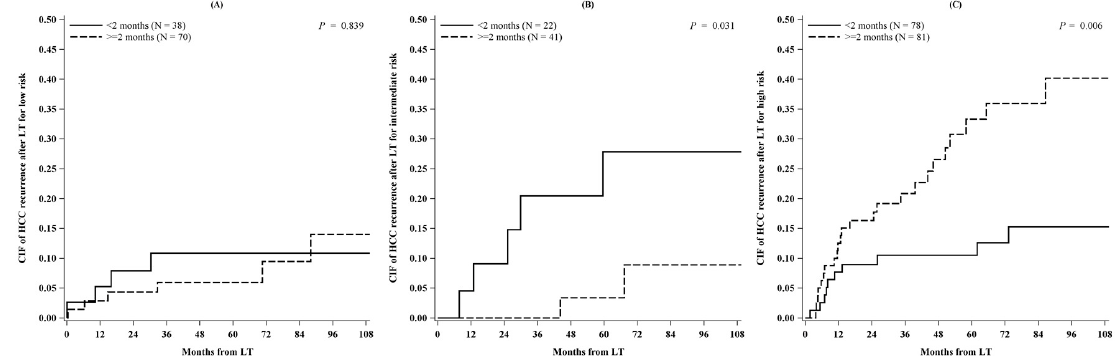
Figure 3. Cumulative incidence of HCC recurrence after liver transplantation for ( A ) low, ( B ) intermediate and ( C ) high risk stratified between transplanted patients within 2 months and after 2 months from restaging ( N = 330).